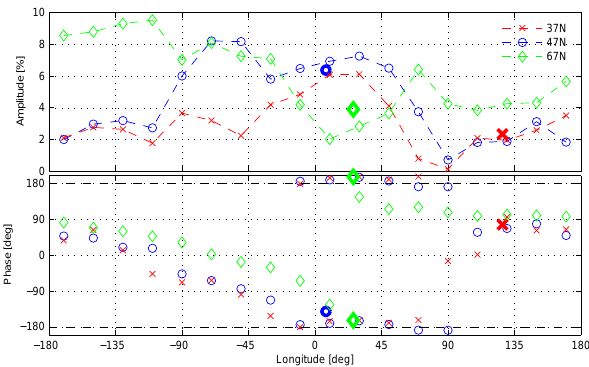
Figure 7. Analogous to Fig. 6 but for the 16-day